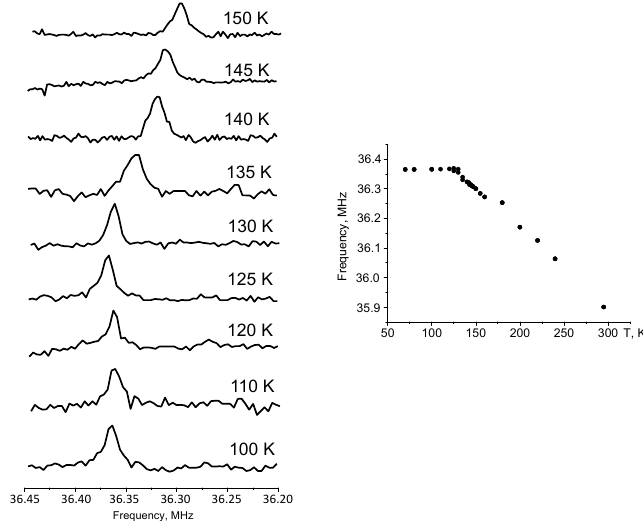
50 100 150 200 250 300